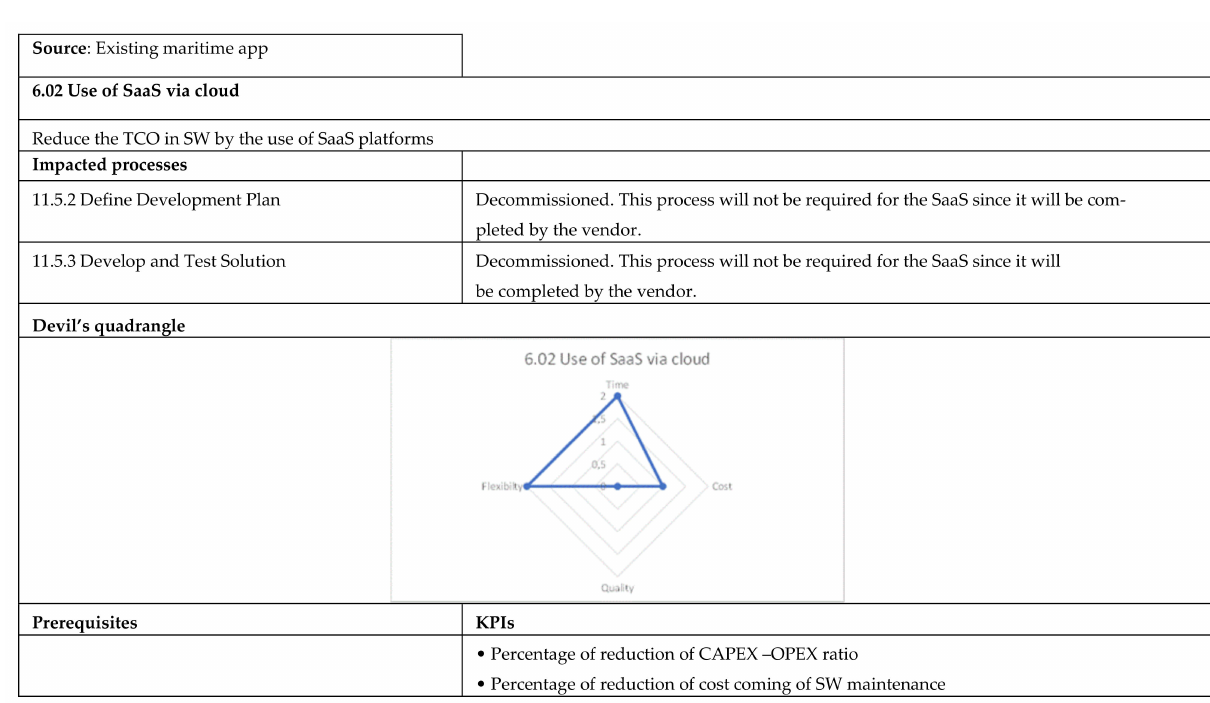
Figure A39. Cloud/Edge platform data sheet.